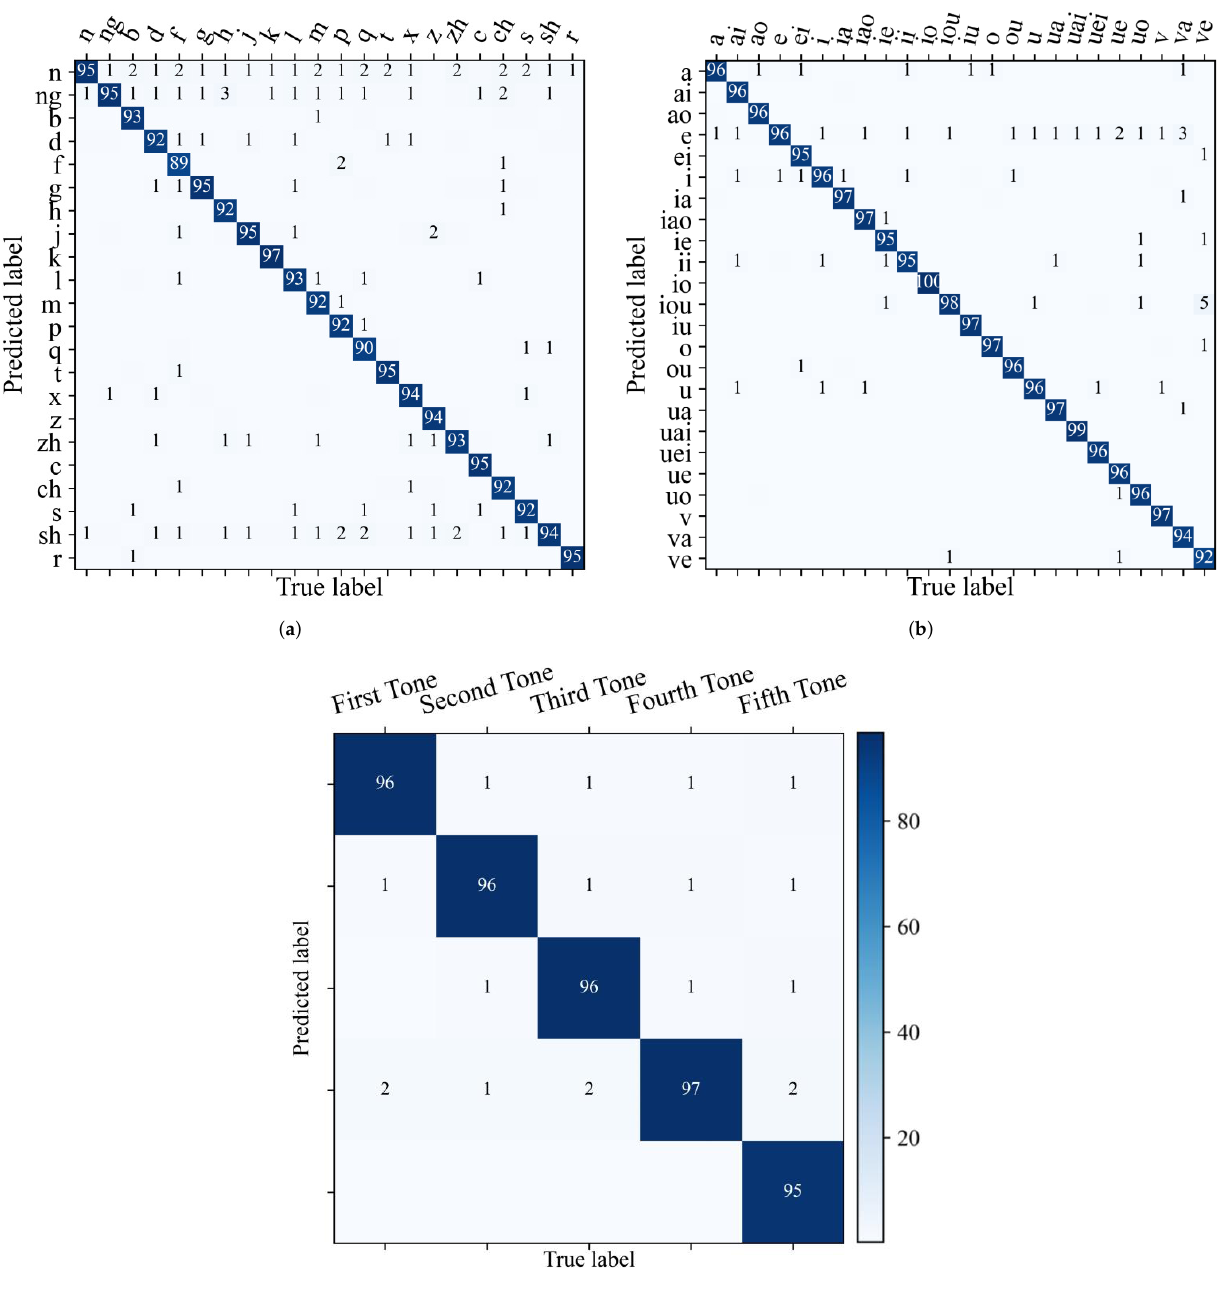
Figure 11. Toneme confusion matrices on the testing set, with the number in row j, column i is the ratio in percentage of the number of samples predicted as label j with the true label i to the number of samples with the true label i. Values smaller than 0.5% are ignored. ( a ) Consonant confusability, ( b ) vowel confusability, ( c ) tone